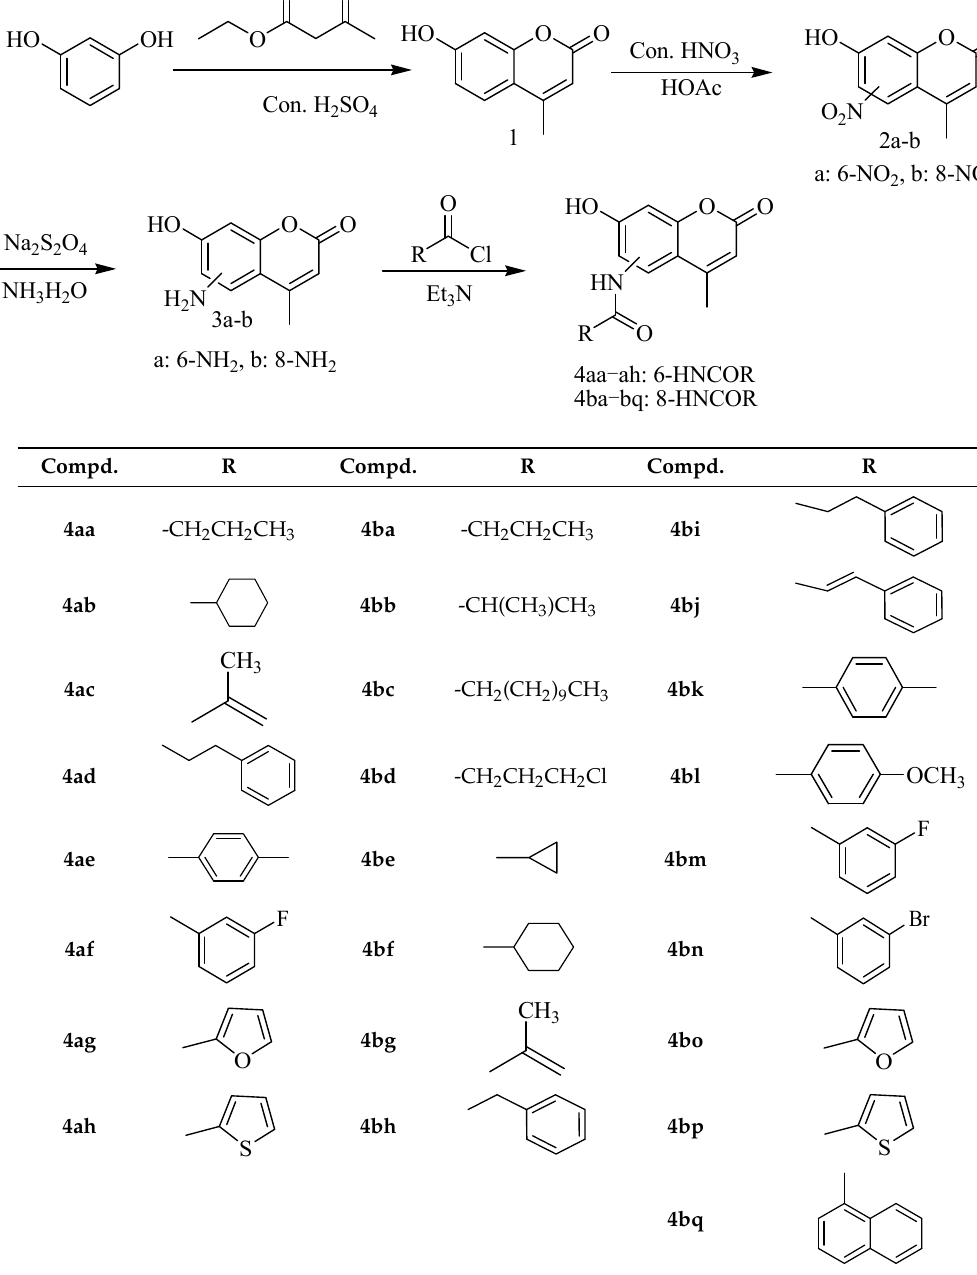
Scheme 1. Synthetic route of target compounds.